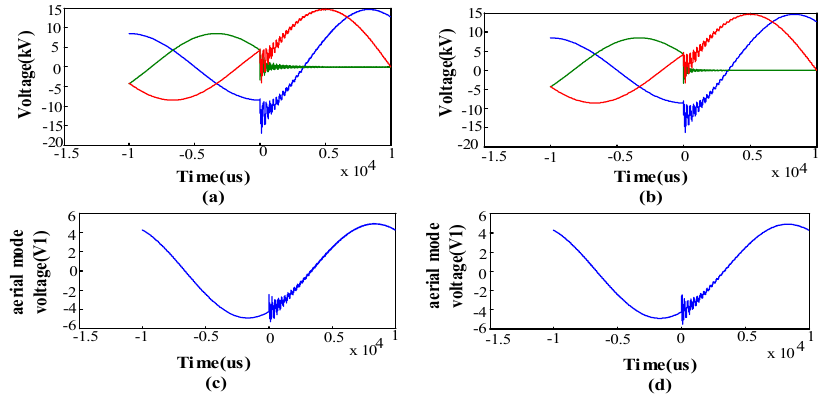
Figure 14. The voltage TWs and their aerial-mode components for a phase-to-ground fault on a long branch. ( a ) The voltage TW measured at measurement unit 2; ( b ) The voltage TW measured at measurement unit 3; ( c ) The aerial-mode component of ( a ); ( d ) The aerial-mode component of ( b ).